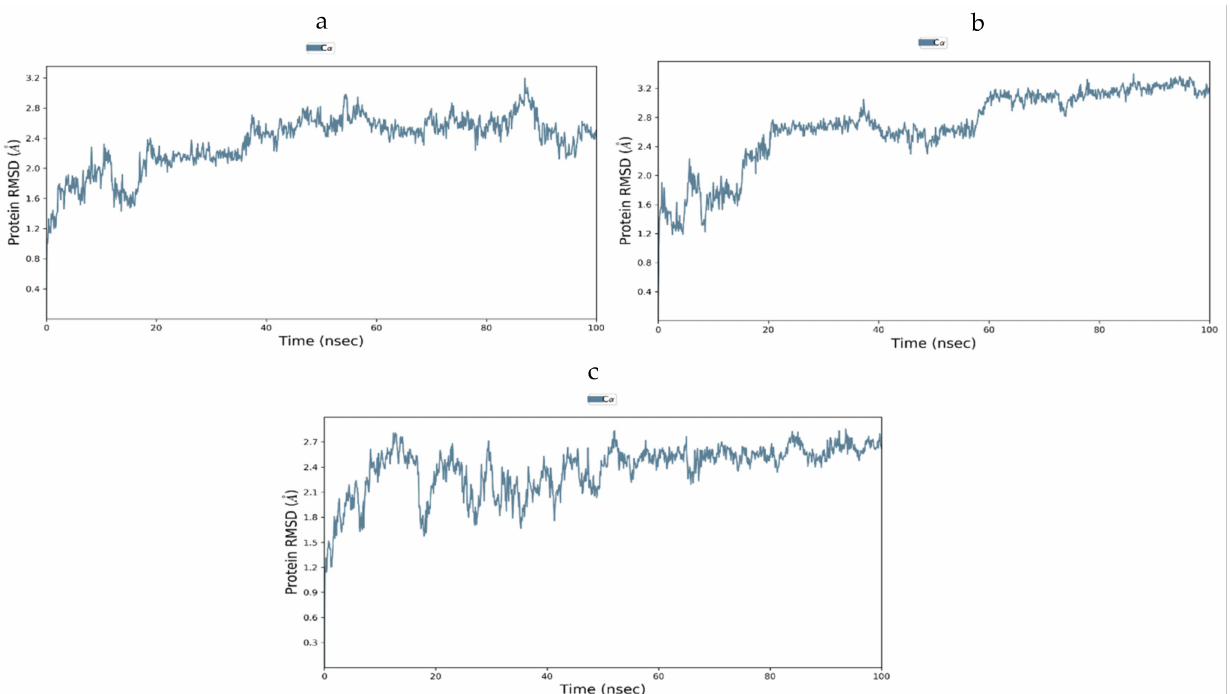
Figure 14. ( a – c ) RMSD plots for GLUT-4 with selected compounds: ( a ) Quercitin, ( b ) Kaempferol, and ( c ) Trans-Ferulic Acid.